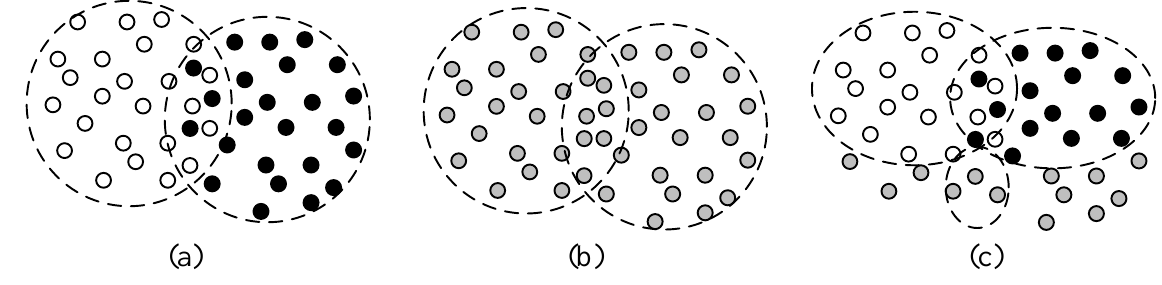
Figure 1. Diagram of uncertain data distribution in decision-making. ( a ) labeled data; ( b ) unlabeled data; ( c ) semi-labeled data;